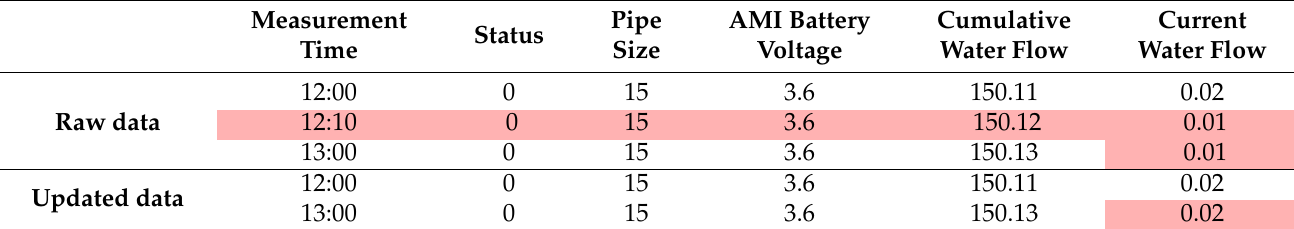
Table 1. Example of data cleaning. The colored AMI data is removed and updated using the proposed data cleaning methods. Measurement